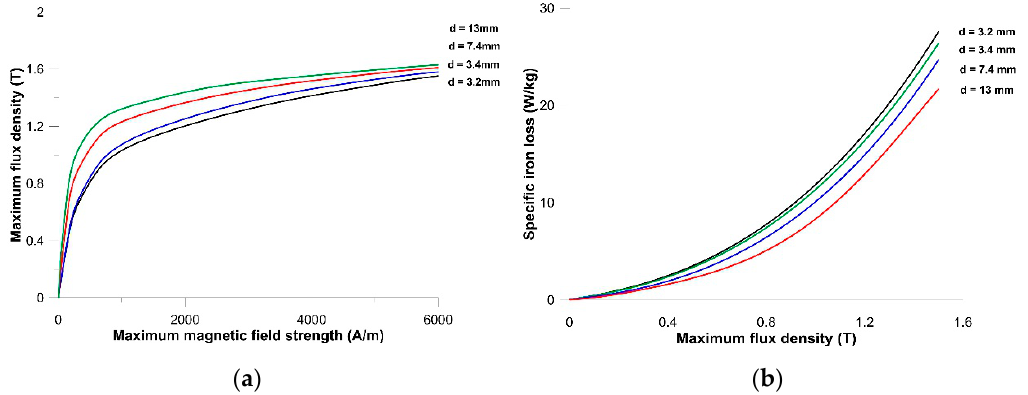
Figure 10. Calculated curves for M250-35A material. The core’s portions widths are shown in the image: ( a ) B 0/90 vs. H ; ( b ) p 0/90 vs. B at 200 Hz.